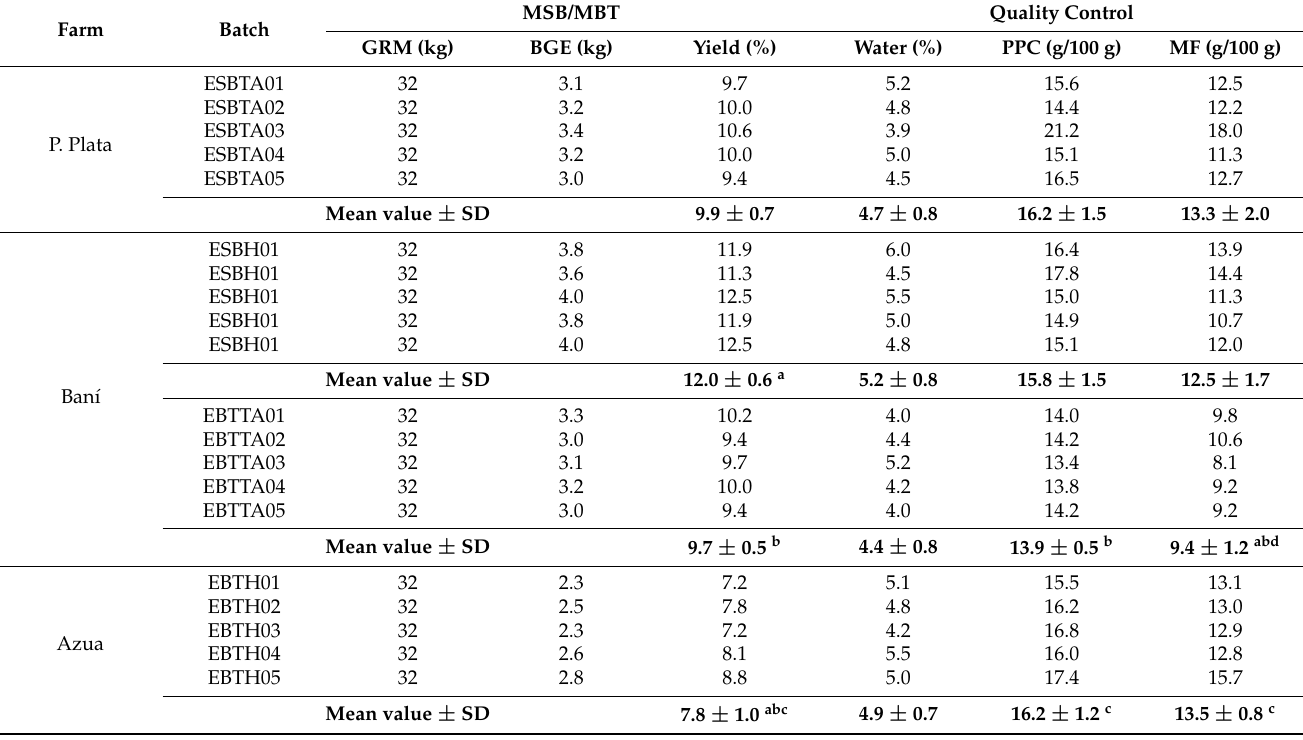
Table 7. Yield and quality determinations of mango bioactive green extract.